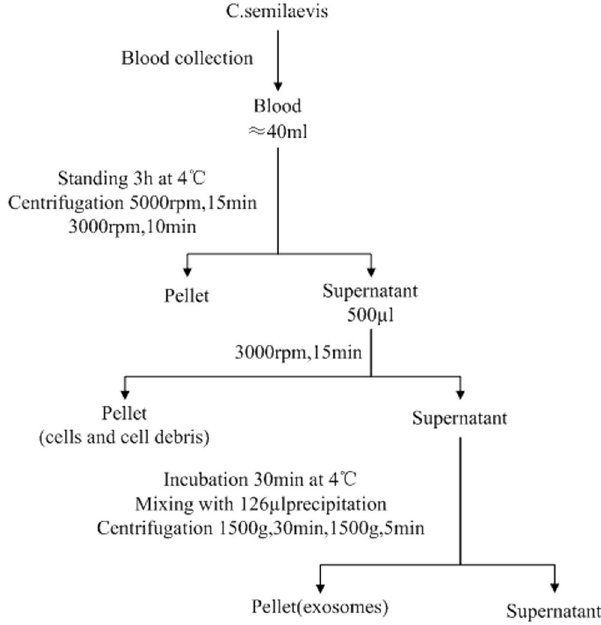
Figure 8. Flowchart for exosomes isolation from C. semilaevis